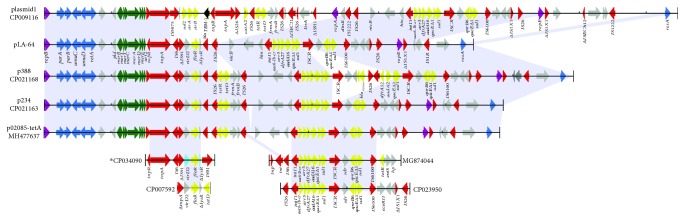
Comparative genomic analysis of pLA-64 and homologous sequences from other plasmids. plasmid1 (CP009116.1), from a K. pneumoniae strain isolated from the human; p388 (CP021168.1), from E. cloacae strain 388 isolated from the human; p234 (CP021163.1), from E. cloacae strain 234 isolated from the human; p02085-tetA (MH477637.1), from C. freundii strain 1509-02085 without origin information; CP034090.1, the chromosome of P. mirabilis strain PmSC1111 isolated from swine; CP007592.1, the chromosome of E. coli O157:H16 Santai isolated from the duck; MG874044.1, plasmid pSa76-CIP of Salmonella sp. without origin information; and CP023950.1, plasmid unnamed3 of K. pneumoniae FDAARGOS_447 isolated from the human. Genes with different functions are shown in different colors: red: transposable elements; yellow: drug resistance; green: heavy metal resistance; blue: backbone; purple: replication; gray: genes with other functions.